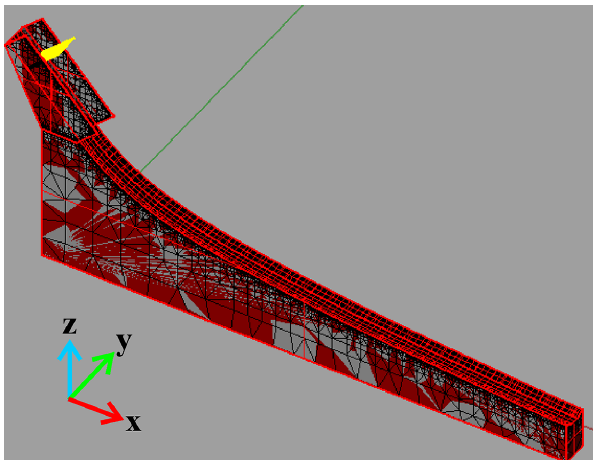
Figure 2. Example of a three-dimensional virtual channel generated by means of a CAD software (Rhinoceros) for the numerical simu- lations. The concave upward channel is shown in red and the gate in yellow.